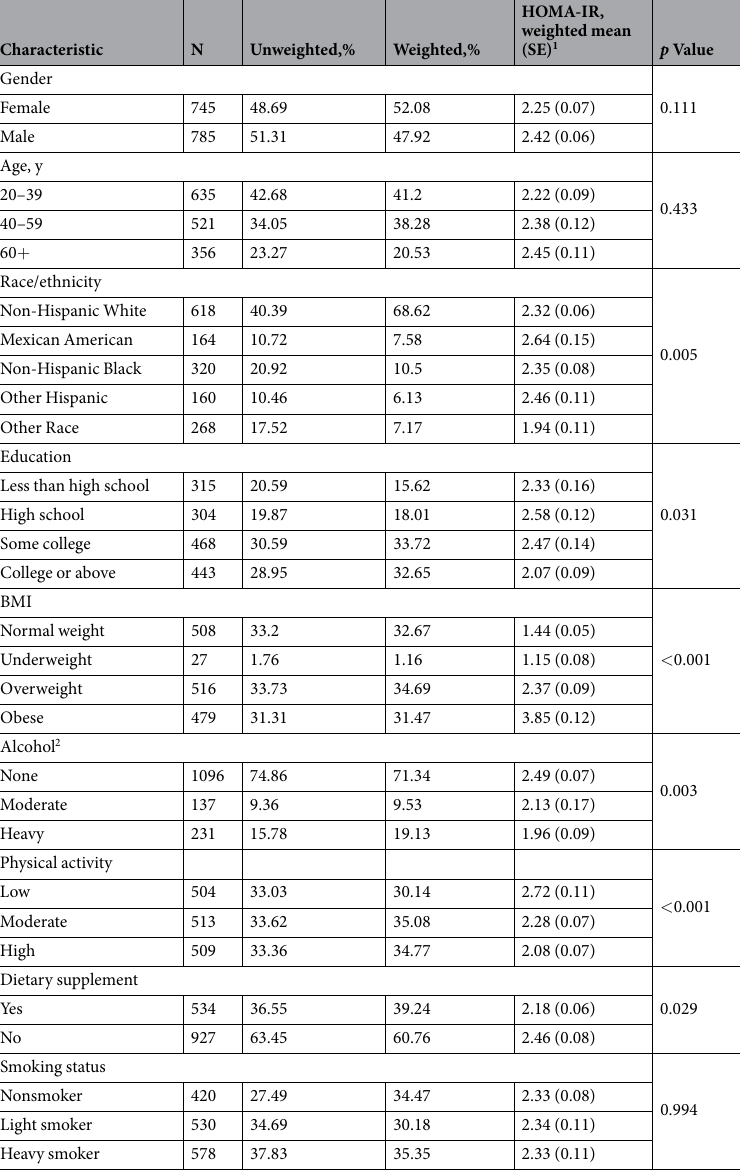
Table 1. Characteristics of study population, NHANES 2011–2012. 1 Geometric Mean. 2 Moderate alcohol consumption was defined as more than none but no more than one drink a day for women and up to two drinks a day for men, according to current guidelines of the USDA, 1 drink = 14 g